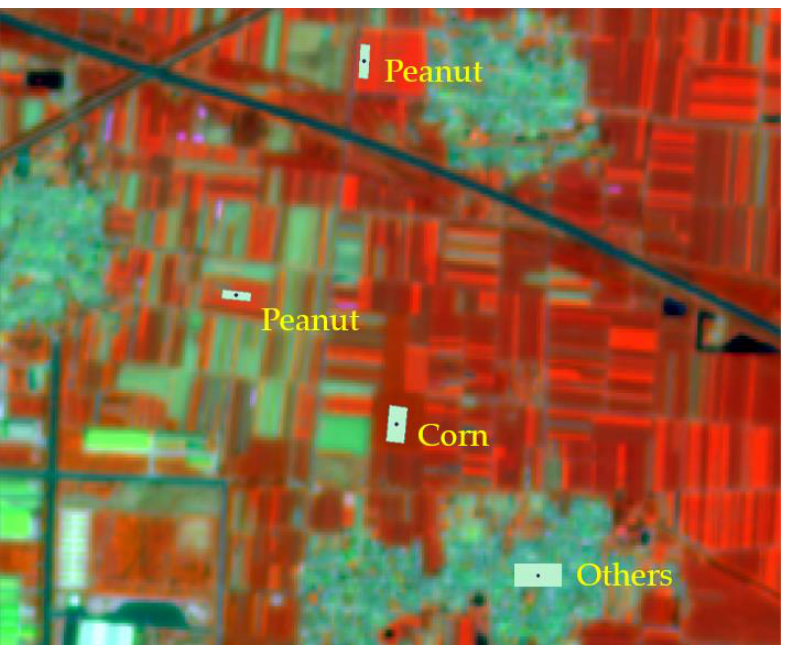
Figure 5. Example of sample expansion. The point vectors are obtained through ground surveys, and the surface vectors are obtained through manual interpretation based on the point vectors. The expanded crop samples are assumed to be manually interpreted inside crop